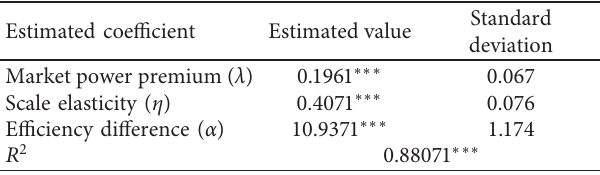
Table 3: The tool variable estimation results of 2SLS model. Estimated